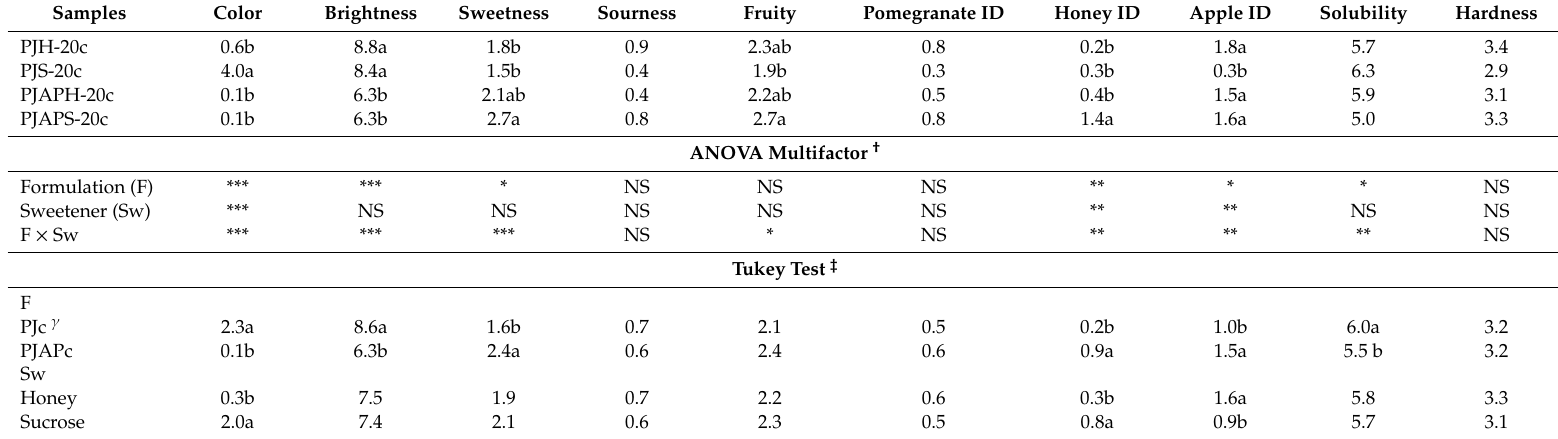
Table 4. Variation of formulation and sweetener on descriptive sensory attributes of pomegranate jelly candies (PJH, PJS, PJAPH, PJAPS). Samples Color Brightness Sweetness Sourness Fruity Honey ID Apple